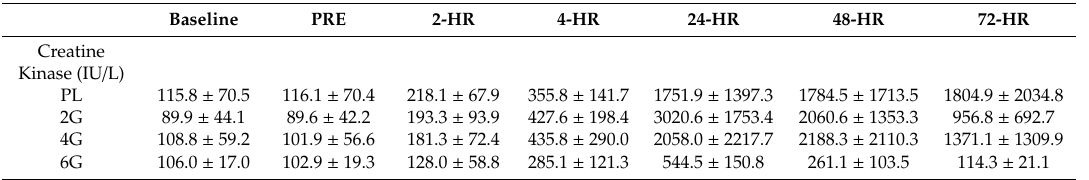
Table 5. Creatine kinase (CK) and lactate dehydrogenase (LDH) blood values for each group at all time-points. n = 8 / group; 4 males and 4 females per group. Baseline